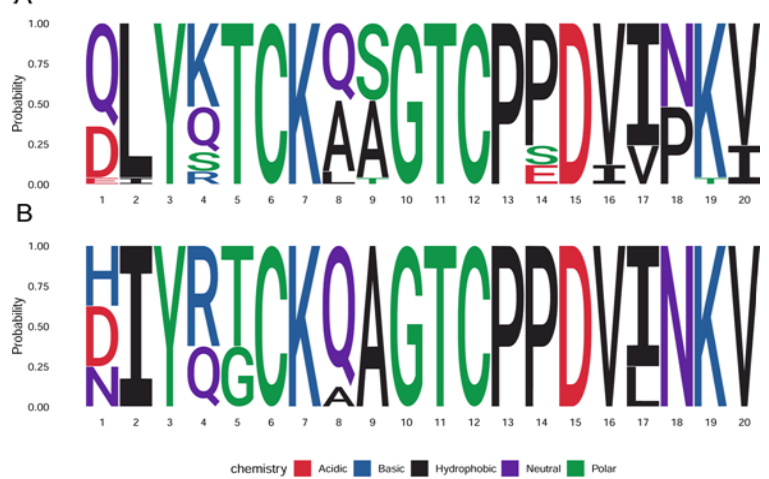
Figure 2. Designing consensus sequences within a conserved protective epitope of L2 of alpha and beta HPV genotypes. Plot of the probability of listed amino acids at given position within the RG-1 sequence (i.e., defined by HPV16 L2 17–36) of L2 of medically significant HPV types. ( A ) Oncogenic or probably oncogenic alpha types (HPV16, 18, 26, 30, 31, 33, 34, 35, 39, 45, 51, 52, 53, 56, 58, 59, 66, 67, 68, 69, 70, 73, 82 and 85). ( B ) EV-associated HPV beta types (HPV 5, 8, 9, 12, 14, 15, 17, 20). The figures were generated using ggseqlogo package in R studio. Table 1. Summary of published L2 vaccine technologies Technology for Display